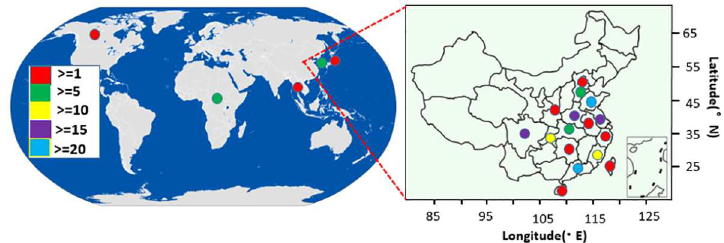
Fig 1. Location of the sweet potato accessions from around the world, highlighting